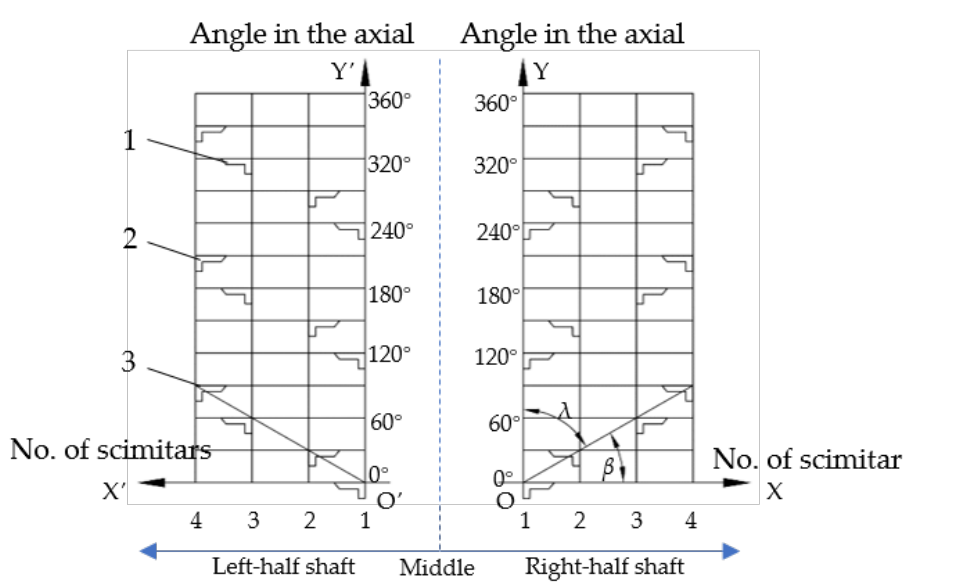
Figure 2. Schematic of axial scimitars’ arrangement of the anti-blocking mechanisms. Note: 1, left scimitar of MIIT245 type; 2, right scimitar of MIIT245 type; 3, spiral line.